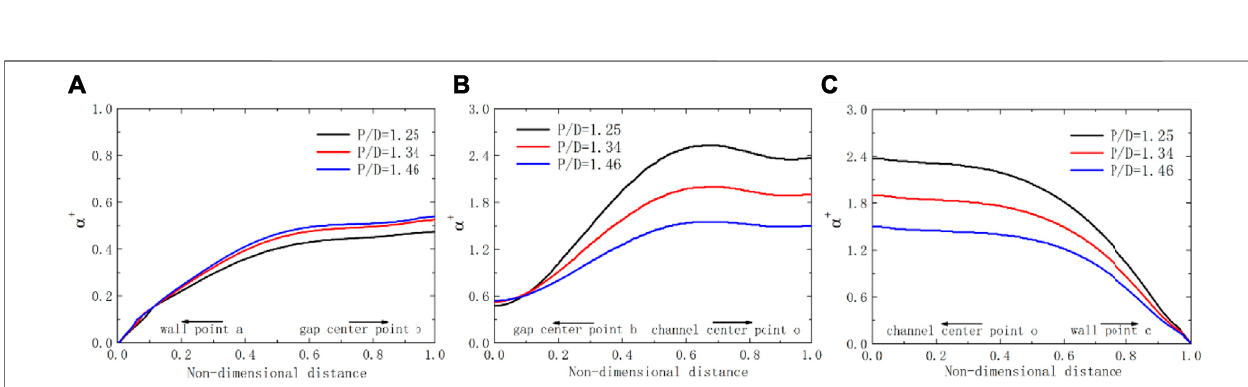
Frontiers in Energy Research |